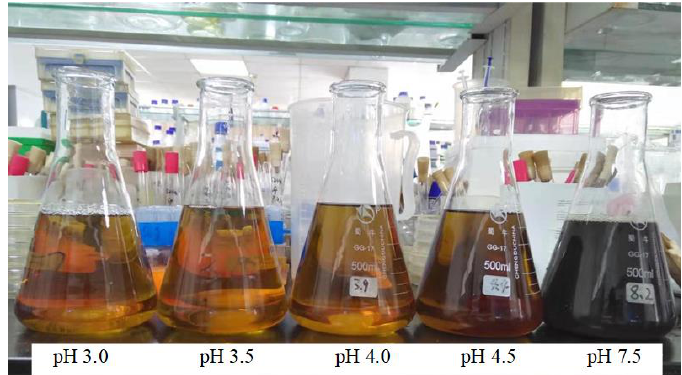
Figure 1. Effect of different pH values on hydrolysate color.